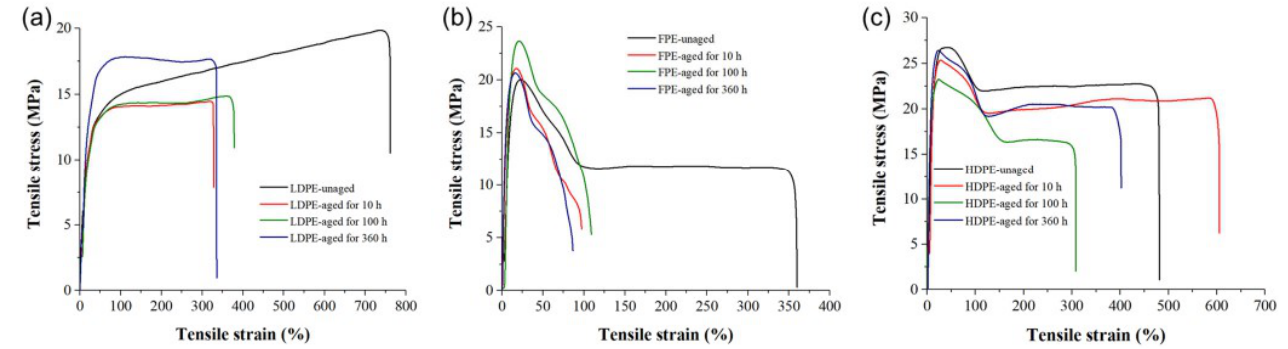
Figure 10. Tensile curves of thermally aged PE samples. ( a ) LDPE, ( b ) FPE, and ( c )